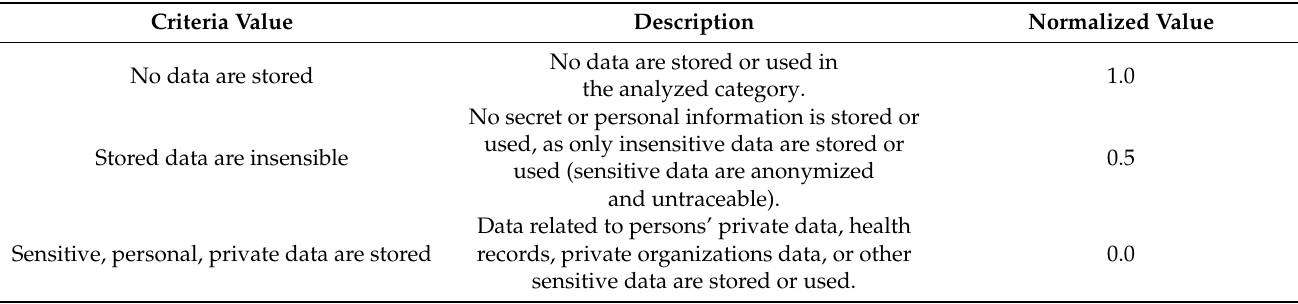
Table 2. Criteria value association to normalized value for sub-criteria data sensibility.